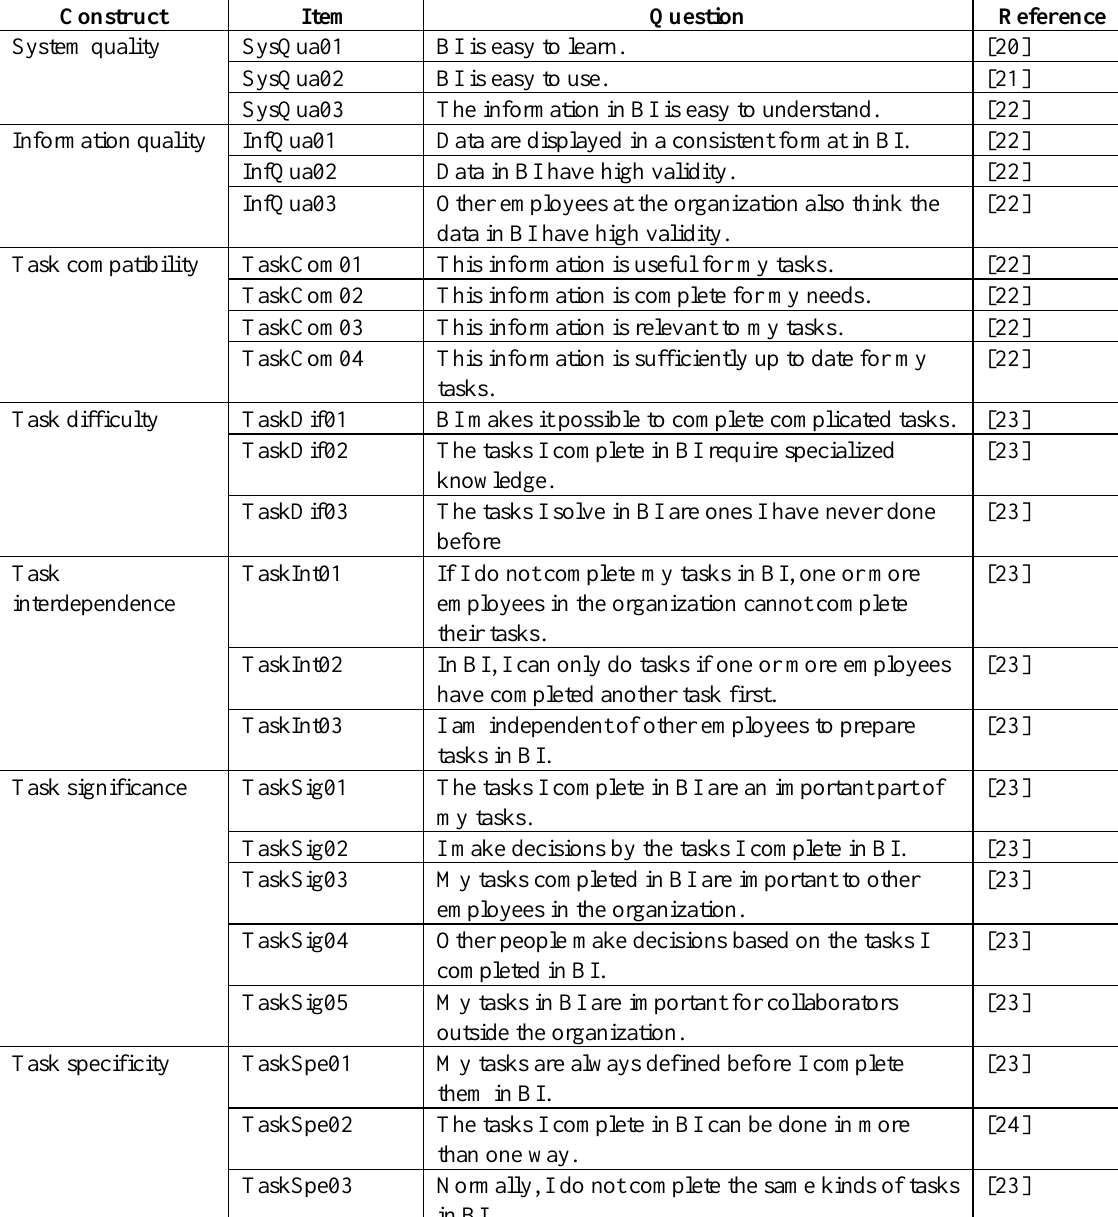
Table 1. Questionnaires used in the